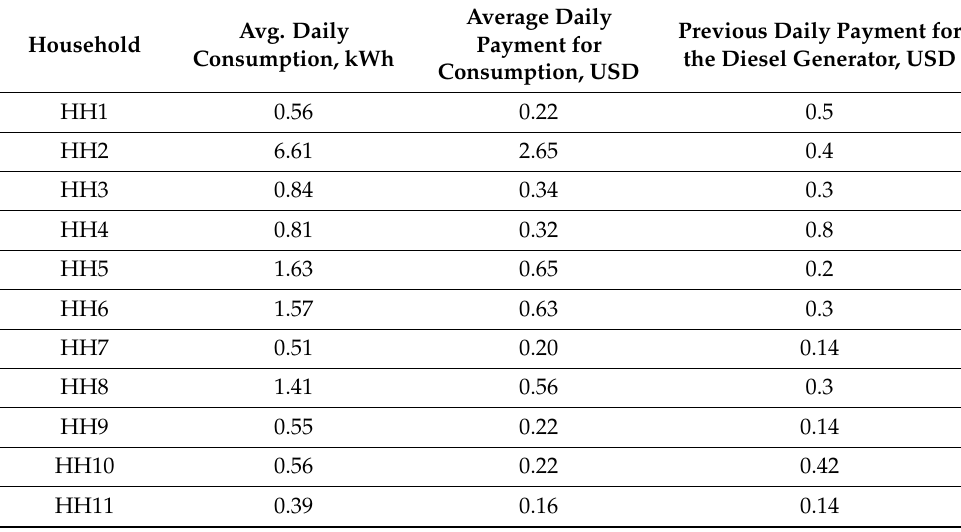
Table 10. Electricity consumption and daily household electricity costs.